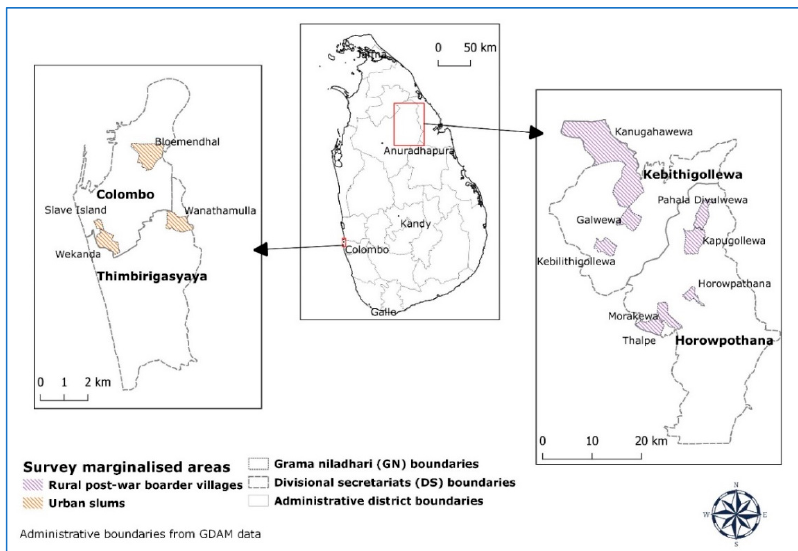
Figure 1. Study map (authors’ illustration).